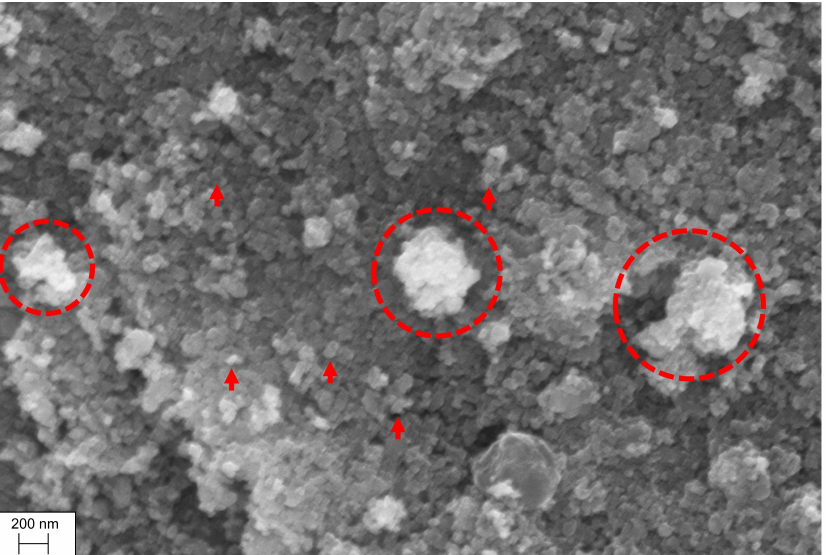
Figure 5. SEM image of TiC nanoparticles on coated AA4043 granule after roll mixing, but before metal screw extrusion. Individual TiC nanoparticles (40–60 nm) are indicated by arrows. Circles show TiC clusters up to a size of ∼ 400